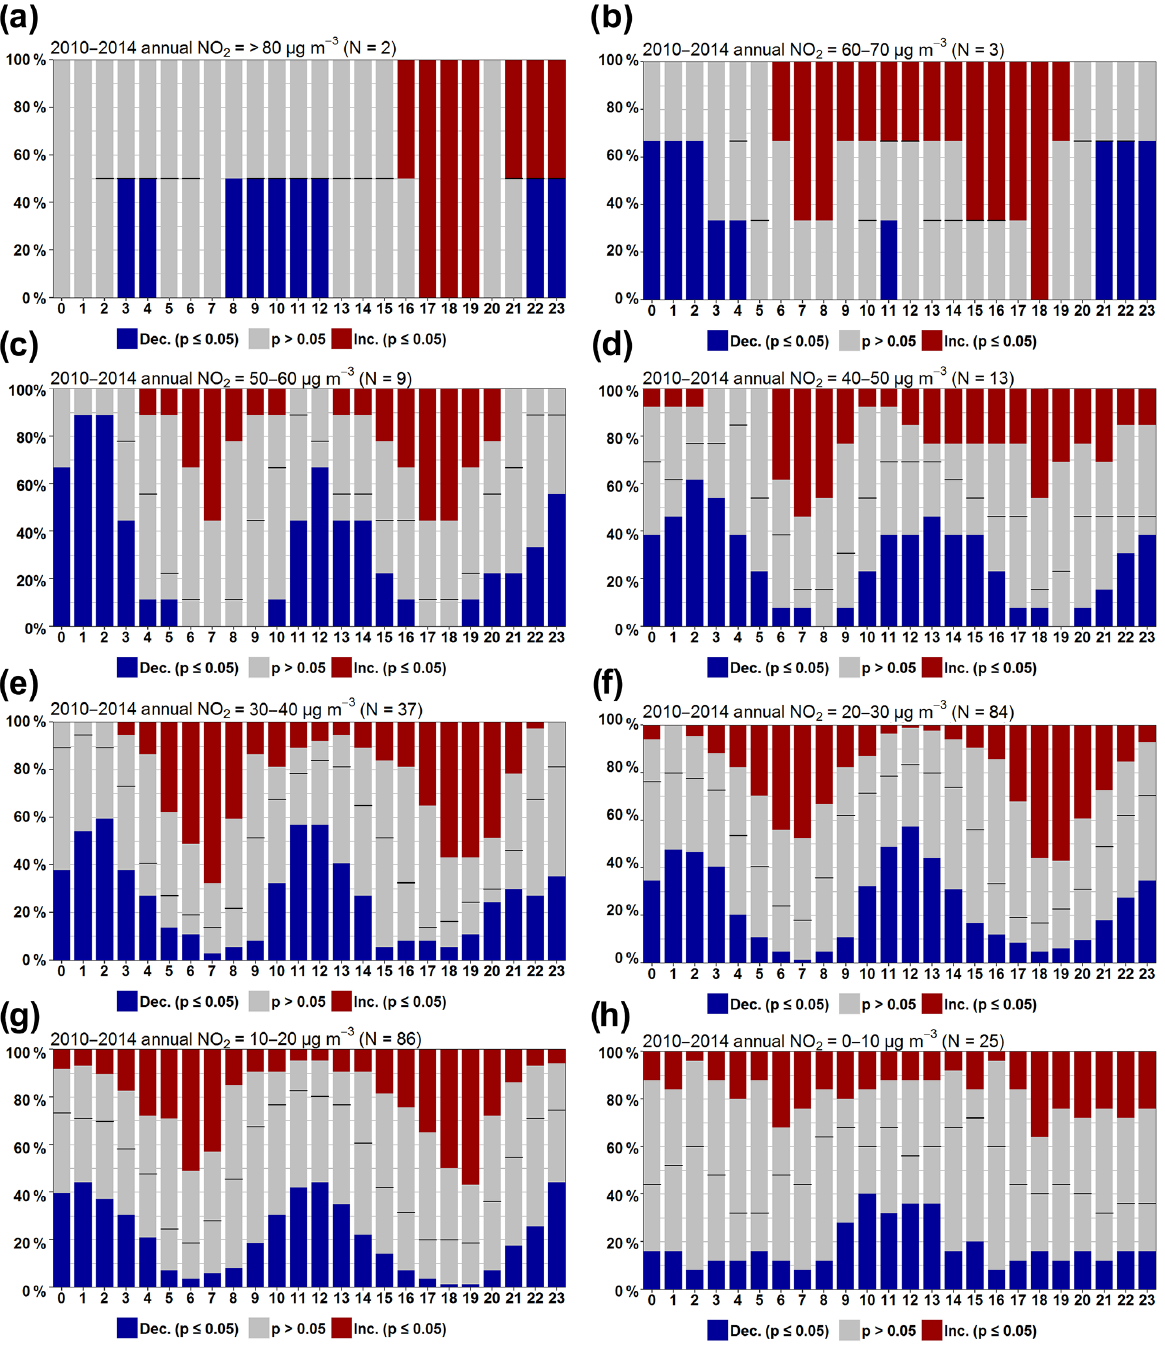
Figure 11. Proportion of sites with significant decreasing (blue), increasing (red) ( p ≤ 0.05), and non-significant (grey) trends in the per- centage contribution of each hour of day to annual average NO 2 between 2000 and 2014, for sites with 2010–2014 average annual NO 2 concentrations (NO 2AA ) of (a) >80µgm − 3 , (b) 60–70µgm − 3 , (c) 50–60µgm − 3 , (d) 40–50µgm − 3 , (e) 30–40µgm − 3 , (f) 20–30µgm − 3 , (g) 10–20µgm − 3 , and (h) 0–10µgm − 3 . Trend estimates were calculated using a first-order autoregressive (AR(1)) model. The black line represents the division between decreasing and increasing trends within the non-significant